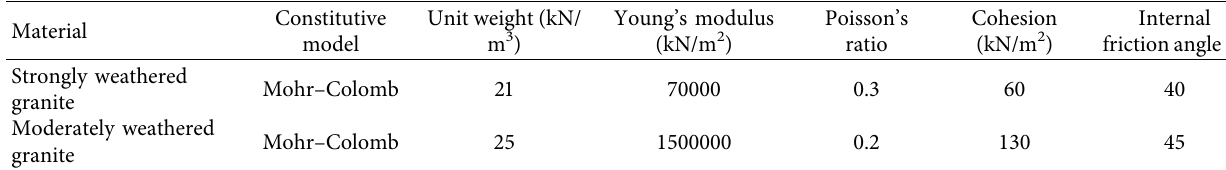
Table 2: Material parameters for numerical analysis.